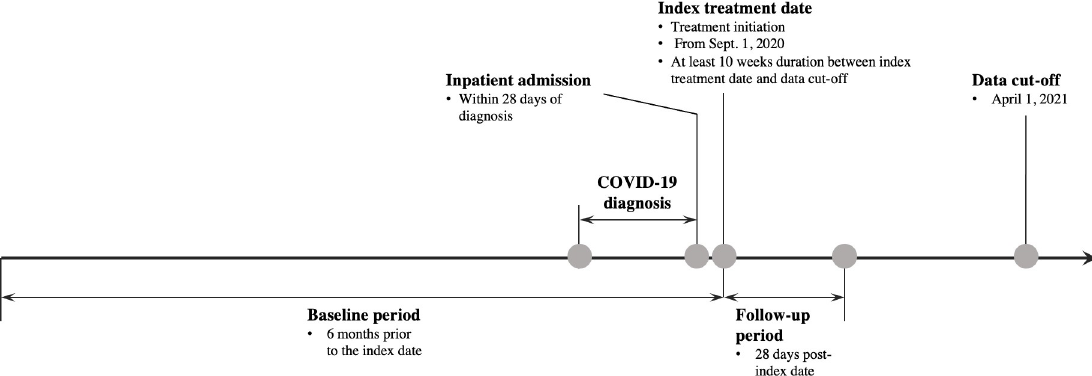
Fig 1. Study design. COVID-19, coronavirus disease 2019. Note: The duration between index treatment date and data cut-off date was at least 10 weeks to allow for full reporting of the deaths that occurred among the patients during the 28 days of follow-up.